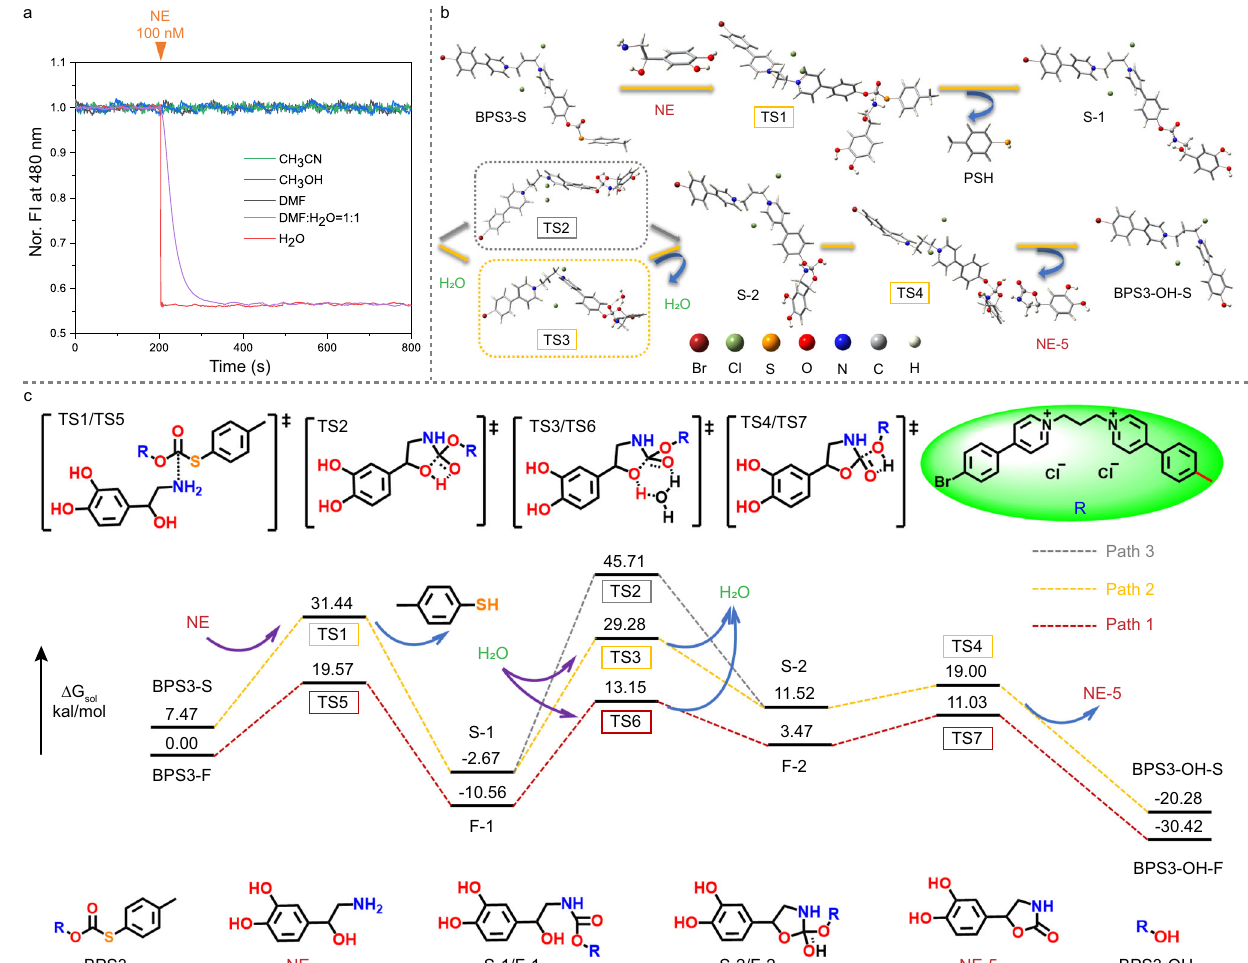
Fig. 4 | Mechanism studies of the water-bridging-boosted reaction kinetics for NEdetection.a Normalized fl uorescenceresponsedynamics(recordedat480nm, excited at 720nm) of 5 μ M BPS3 solution in different solvents with addition of 100nM NE. b The pathway and possible transition states of the reactions between